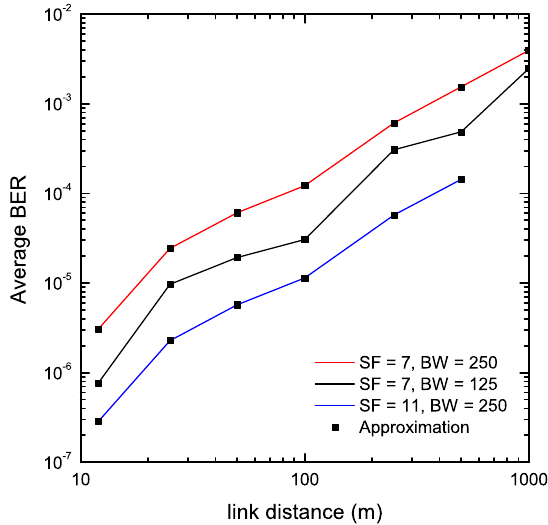
Figure 6. BER estimation of LoRa systems operating in the presence of Rice fading in an agricultural environment using a measurement